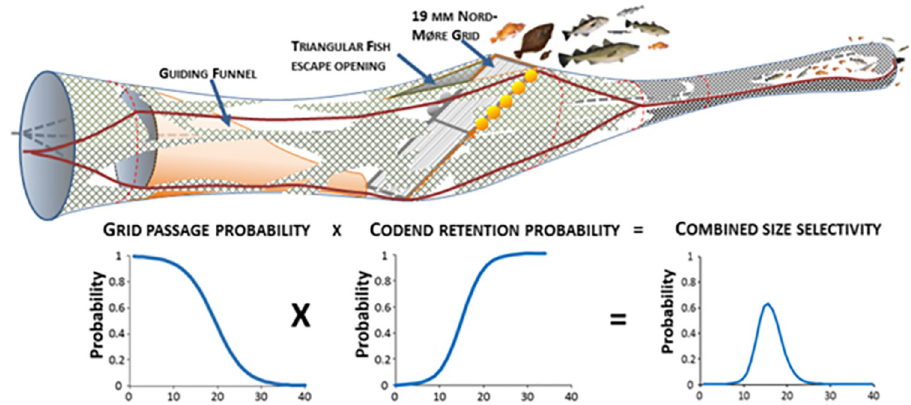
Fig 1. Illustration of the working principle of a sorting system built from a Nordm ø re grid and a subsequent selective codend with curves representing the corresponding size dependent grid passage probability, codend retention probability and the combined size